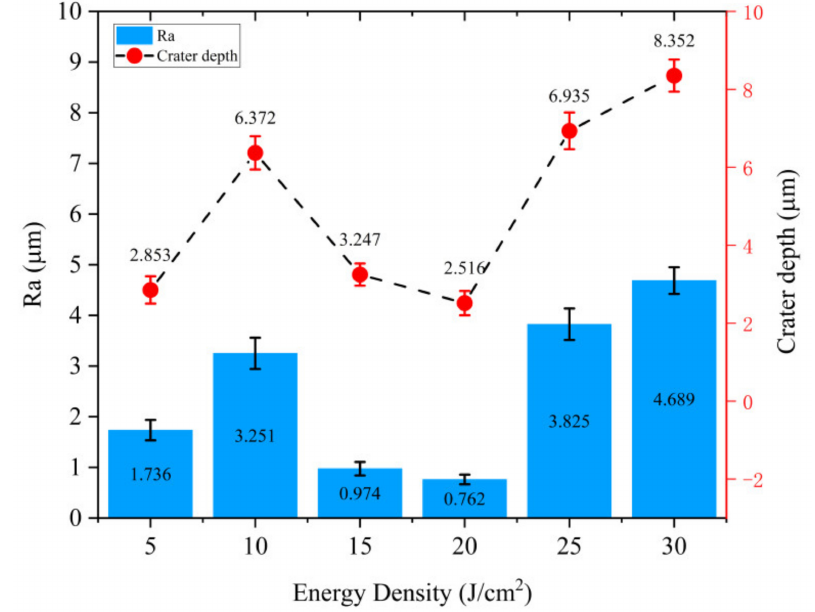
Figure 7. Effect of water jet-guided laser energy density on the surface roughness of samples.